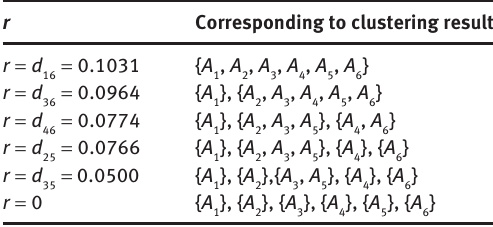
Table 4. Fuzzy MST Clustering